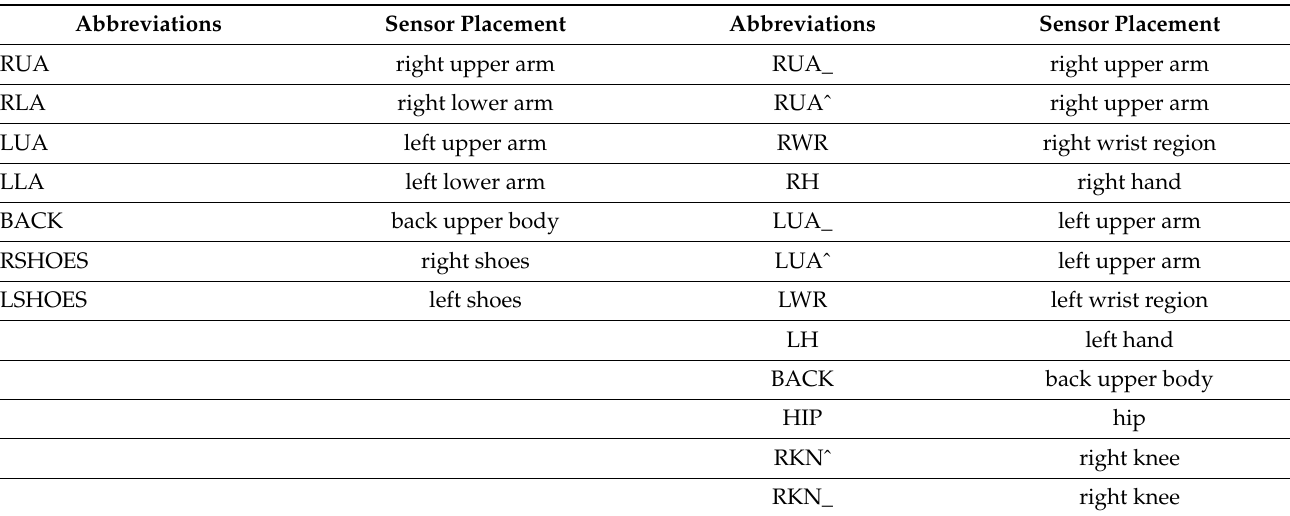
Table 1. Abbreviations for sensor